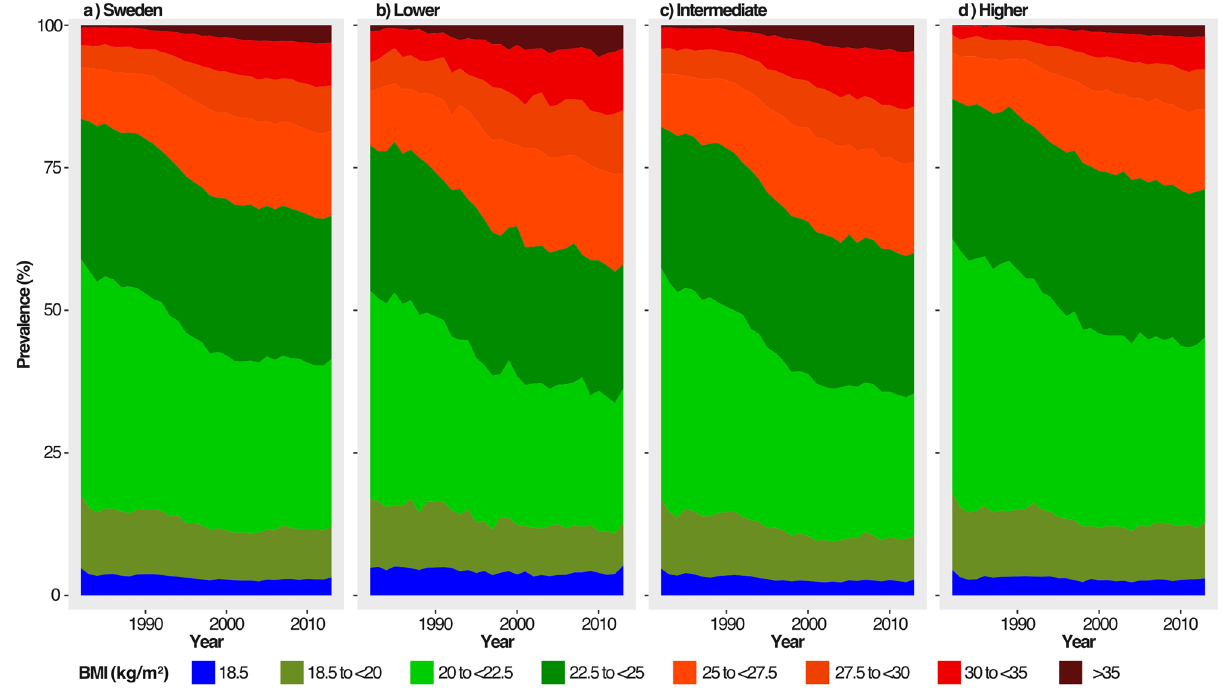
Figure 2. Trends in age-adjusted prevalence of BMI categories. Age-adjusted prevalence of BMI in eight categories from 1982 to 2013. ( a ) All, adjusted for education, ( b ) lower level of education ( c ) intermediate level of education, ( d ) higher level of education. BMI body mass